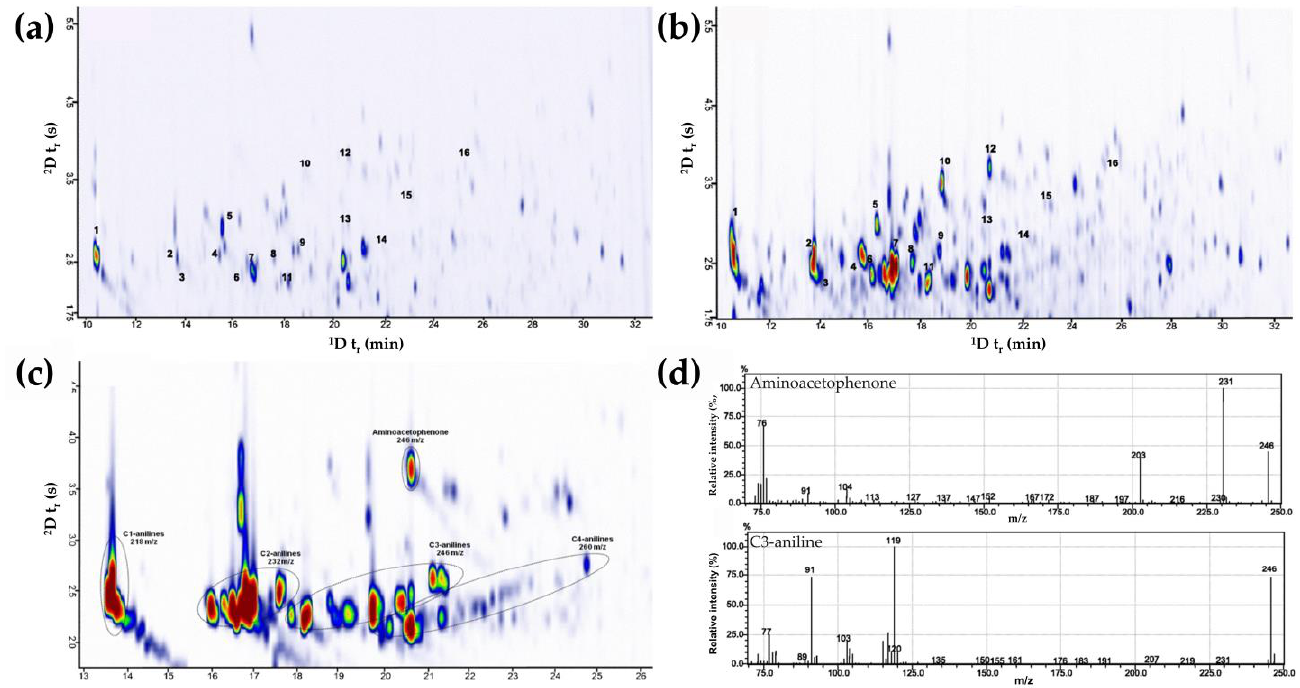
Figure 3. Representative GC × GC chromatograms displaying the presence of aromatic amine derivatives in: ( a ) non-smoker’s urine; ( b ) smoker’s urine; ( c ) smoker’s urine with isomeric homologs of aromatic amines labeled as C1- to C4-anilines and aminoacetophenone ( d ) mass spectra of iodinated derivatives of aminoacetophenone and C3-aniline. Adapted with permission from Ref. [148]. Copyright © 2023 by the authors; Springer Nature Group, Berlin, Germany.